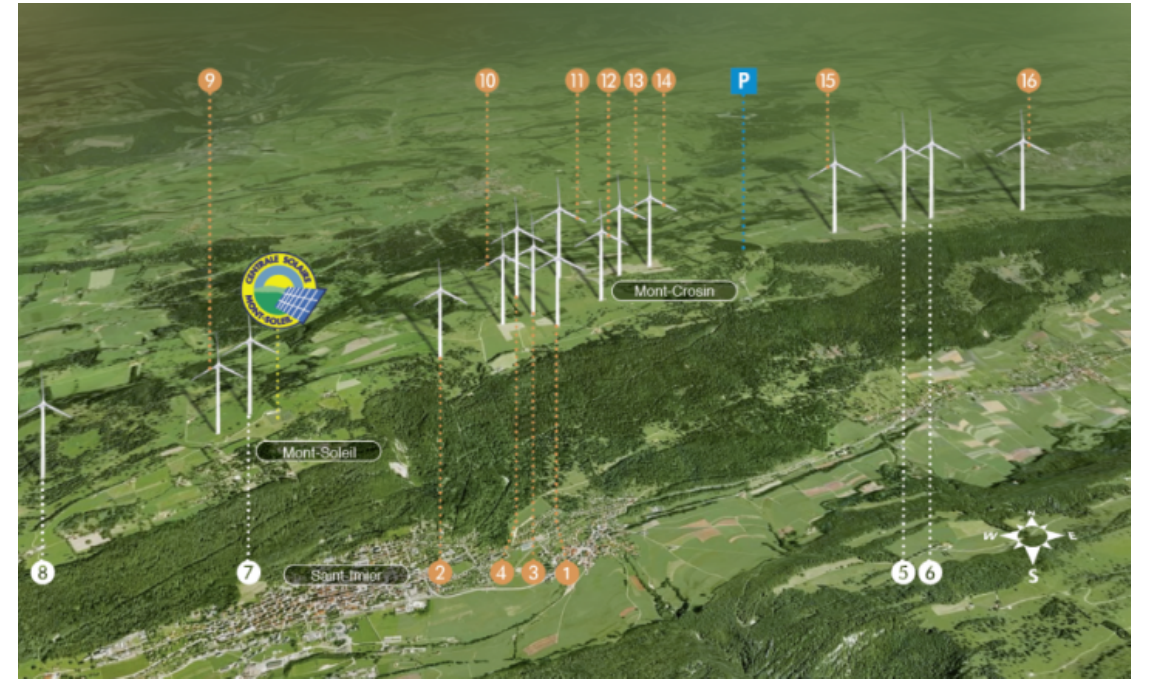
Figure 1. Location of the case study site in the Swiss Jura mountains and numbering of the turbines in the Juvent wind farm (source: